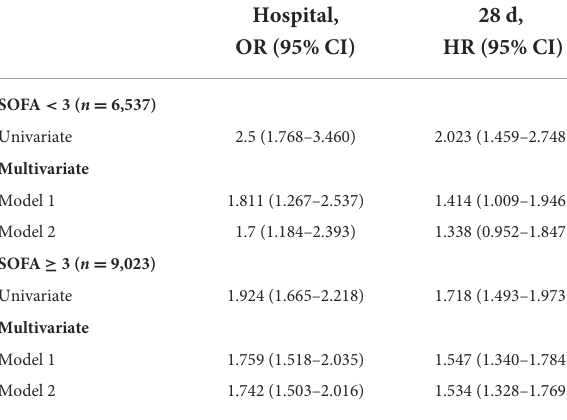
TABLE 3 ORs and HRs with 95% CIs for mortality in patients with different SOFA